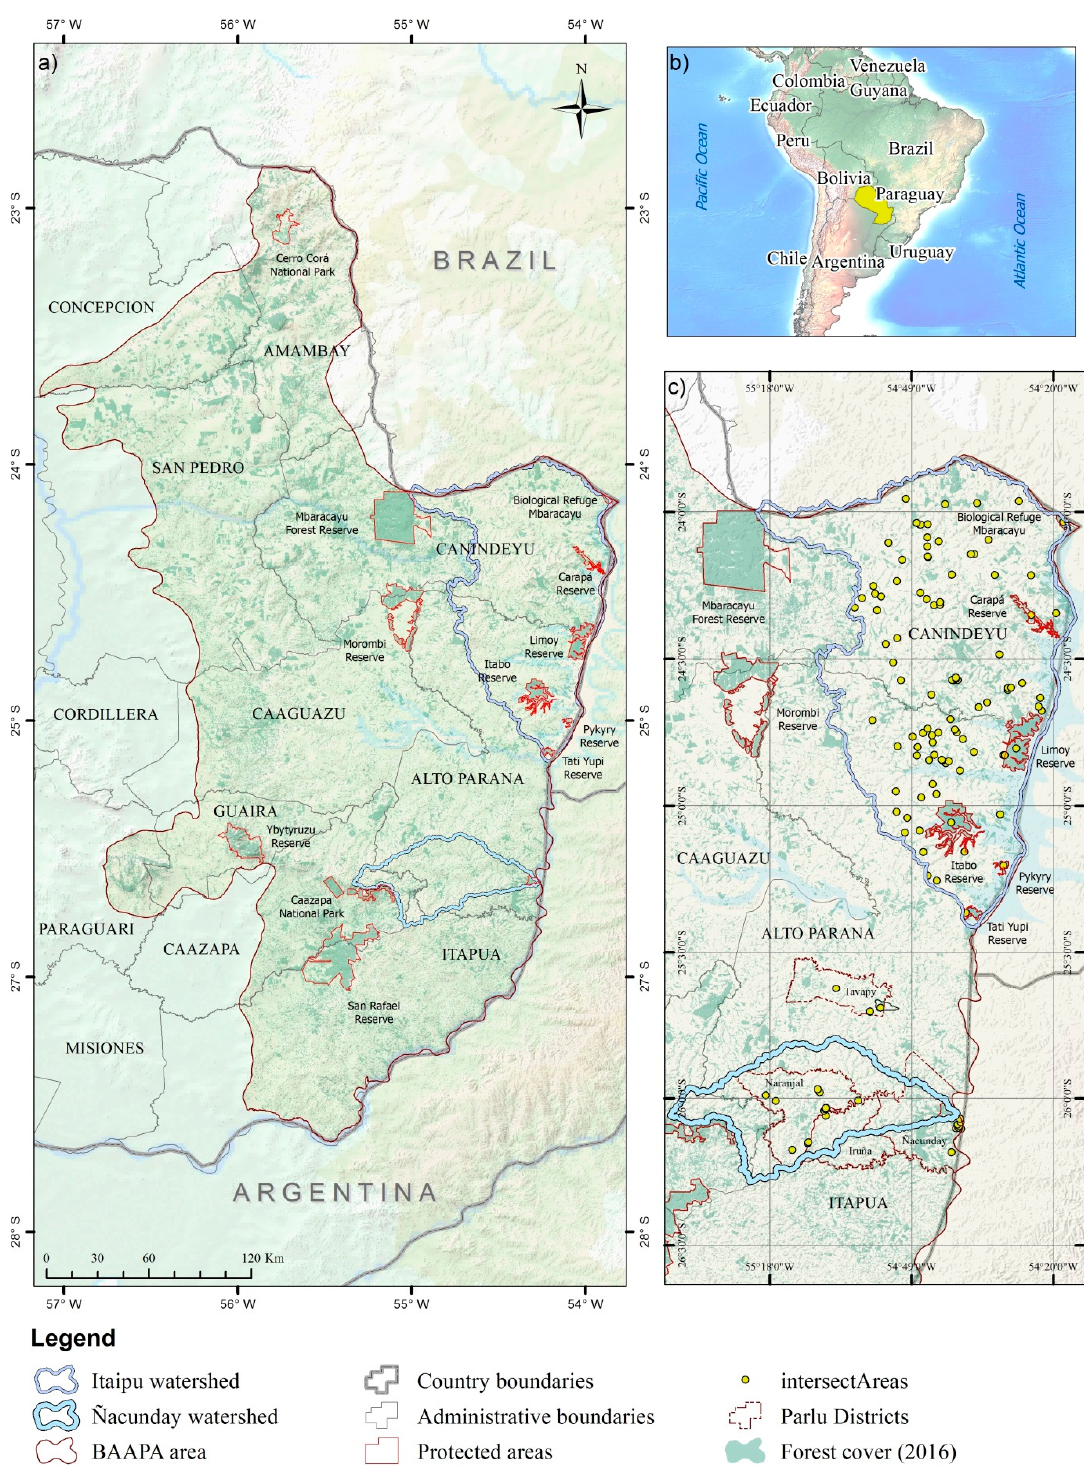
Figure 1. ( a ) Overview of the study area (Base layer provided by Natural Earth Community and Conservation international [26,27]); ( b ) Paraguay and the Upper Parana Atlantic Forest (BAAPA) location (source: adapted from Natural Earth [26]); ( c ) Household distribution within selected study areas.